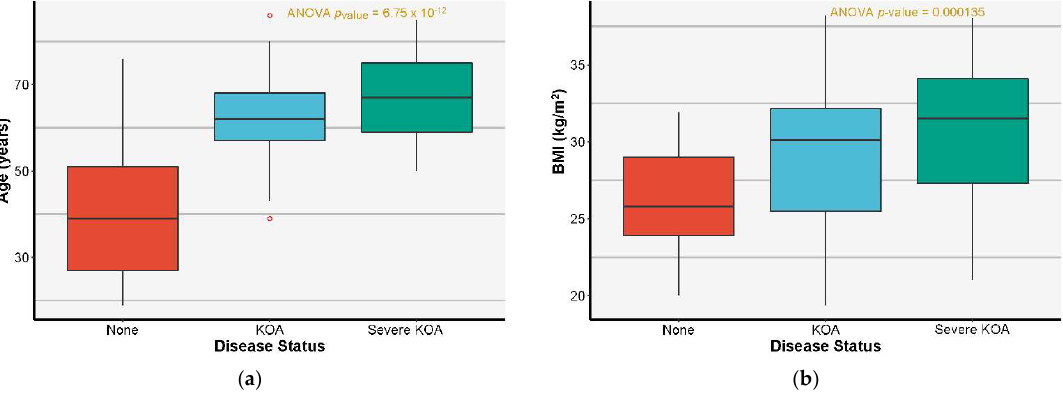
Figure 3. ( a ) Age distribution stratified by KOA severity with the associated ANOVA test p -value. ( b ) BMI distribution stratified by KOA severity with the associated ANOVA test p -value. J. Clin. Med. 2022 , 11 , 7302